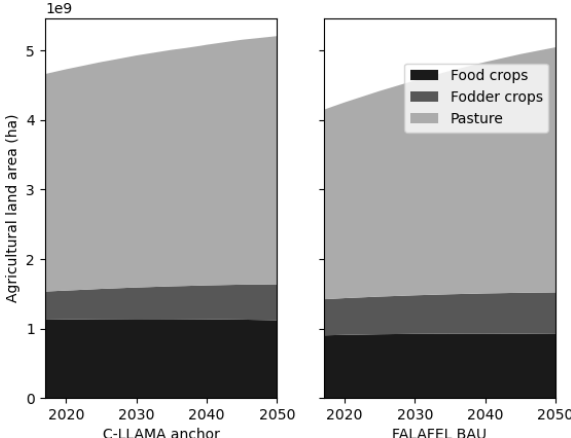
Figure 5. Difference in 2050 global agricultural land use between the anchor scenario (dotted line) and when disallowing the progres- sion of projections in the model by using the 5-year mean of histor- ical values for